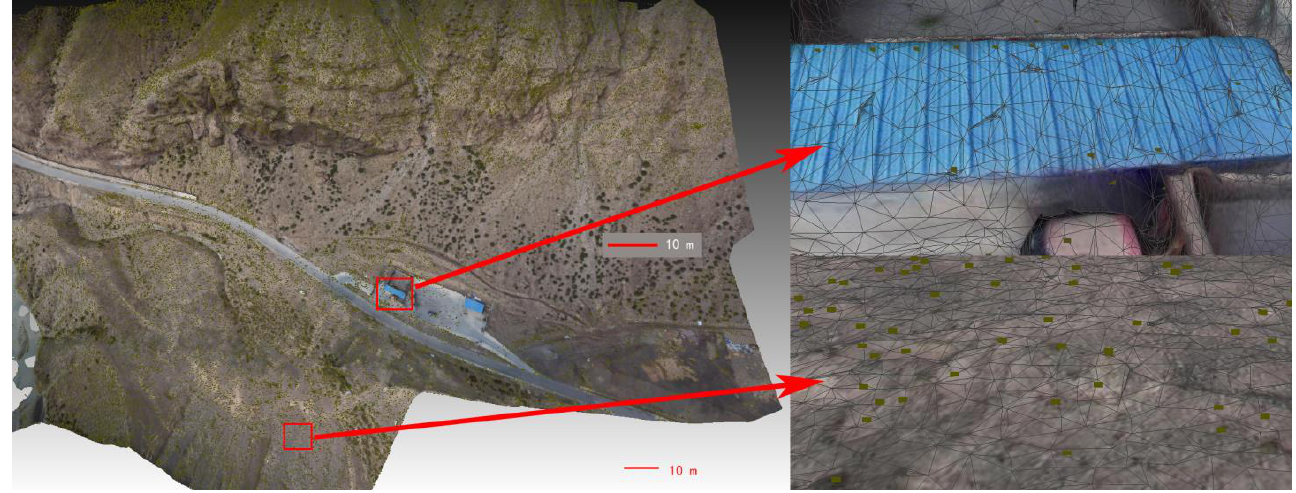
Figure 9. The distribution of feature points in the mesh model.